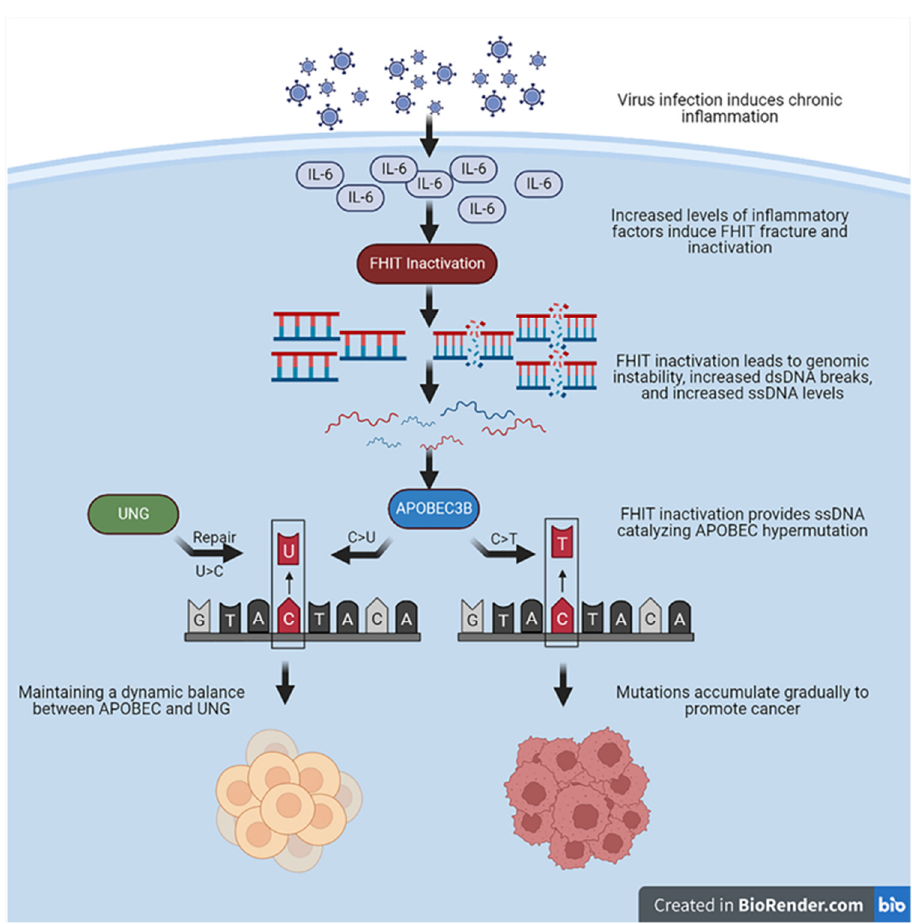
Figure 2. Mechanistic assumptions between FHIT, UNG, and